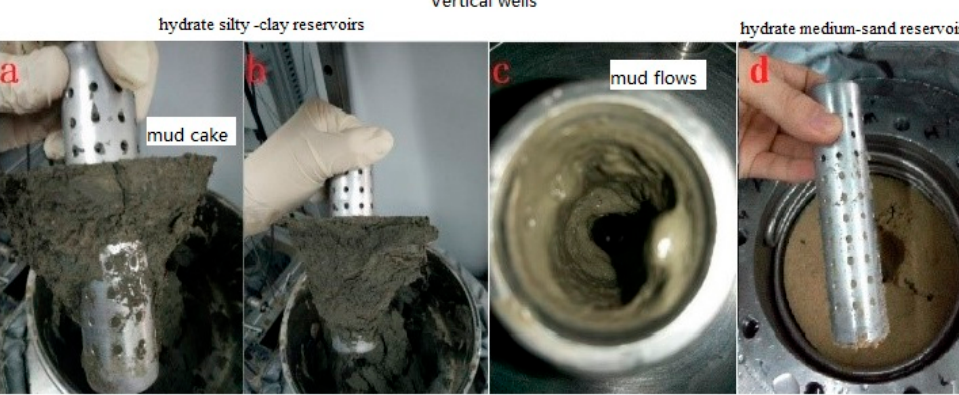
Figure 7. ( a ) The wellbore after production (borehole mud cake); ( b ) mud cake around the wellbore; ( c ) inside the wellbore after production; ( d ) wellbore (medium sand) after production.